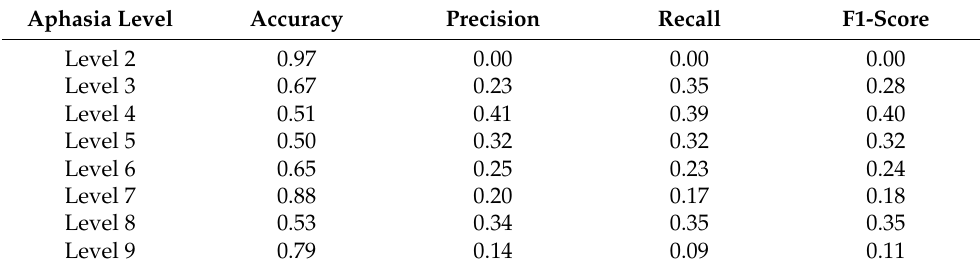
Table 7. Classification report of DNN model for aphasia severity level classification using 10 s audio chunks whose features are extracted using chroma.